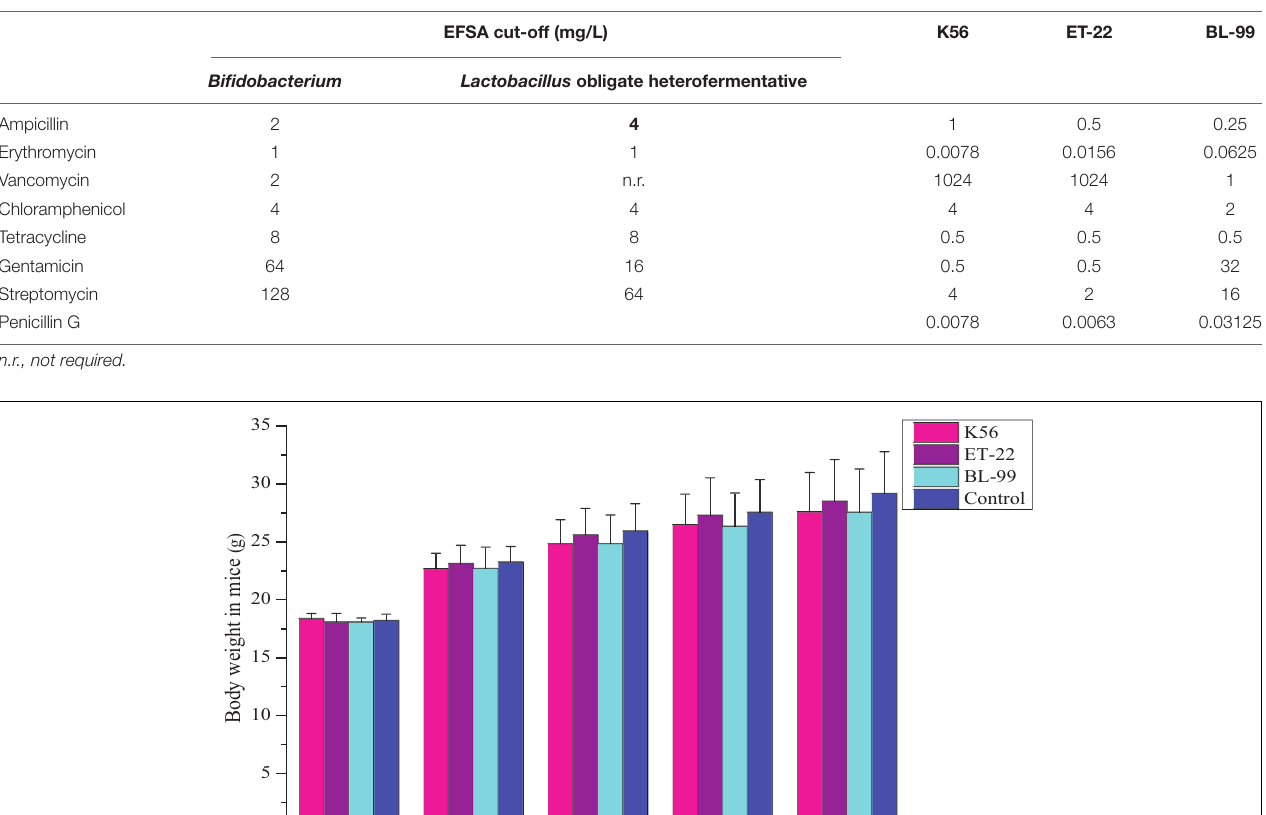
TABLE 3 | Antimicrobial susceptibility (MIC values) of Bifidobacterium lactis BL-99 and Lacticaseibacillus paracasei K56 and ET-22.